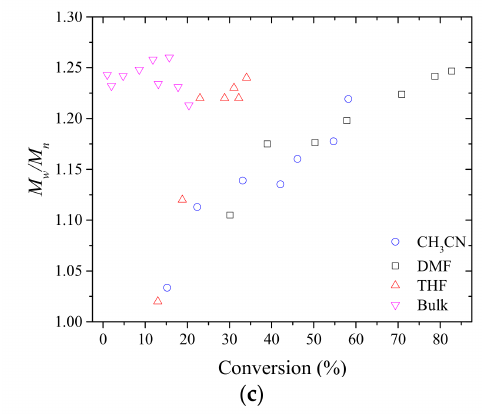
Figure 1. ( a ) The pseudo-first order kinetic plot, ( b ) number average molar mass and ( c ) dispersity index versus conversion plot for the RAFT polymerization of MAC 2 NP 2 in CH 3 CN, DMF, THF, and bulk at 70 ◦